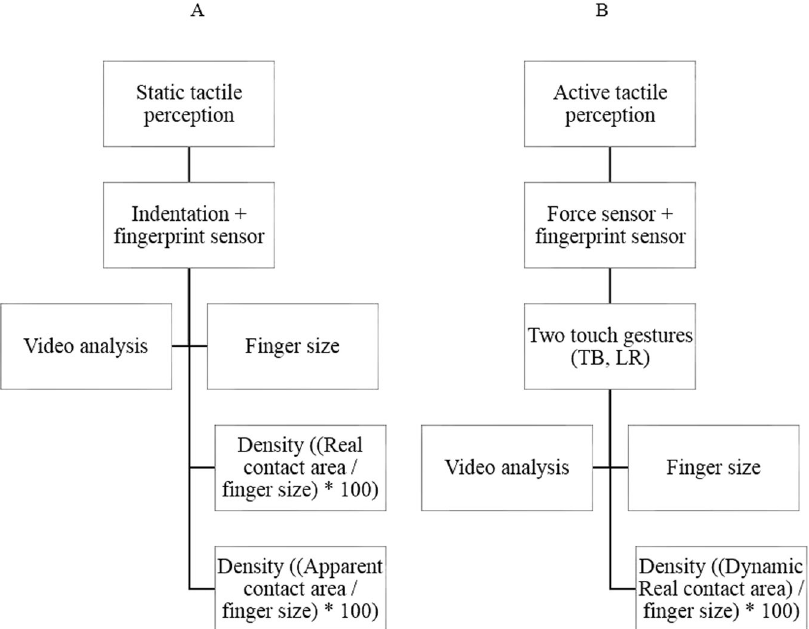
Figure 5. Diagram of the protocol used. ( A ) Static contact, ( B ) dynamic contact.